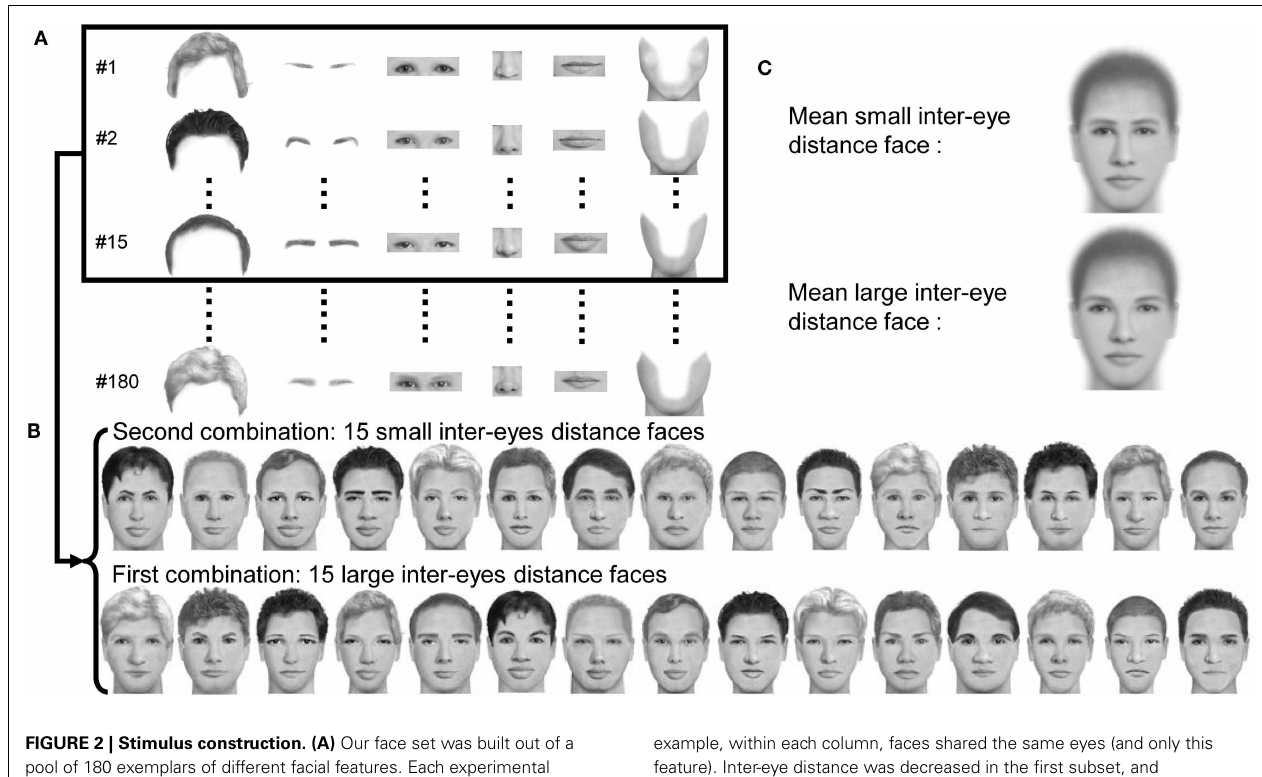
FIGURE 2 | Stimulus construction. (A) Our face set was built out of a pool of 180 exemplars of different facial features. Each experimental block of 30 different faces was built from 15 exemplars of each feature. (B) We drew two combinations of these facial features with the sole constraint that across the two subsets of 15 faces, no face stimulus shared more than one facial feature with any of the other faces. In this